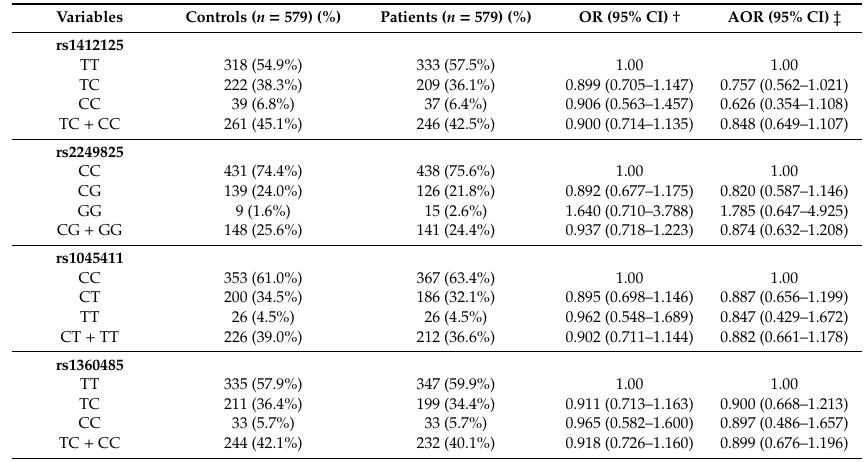
Table 2. Distribution frequency of high-mobility group box 1 (HMGB1) genotypes in 579 control individuals and 579 patients with prostate